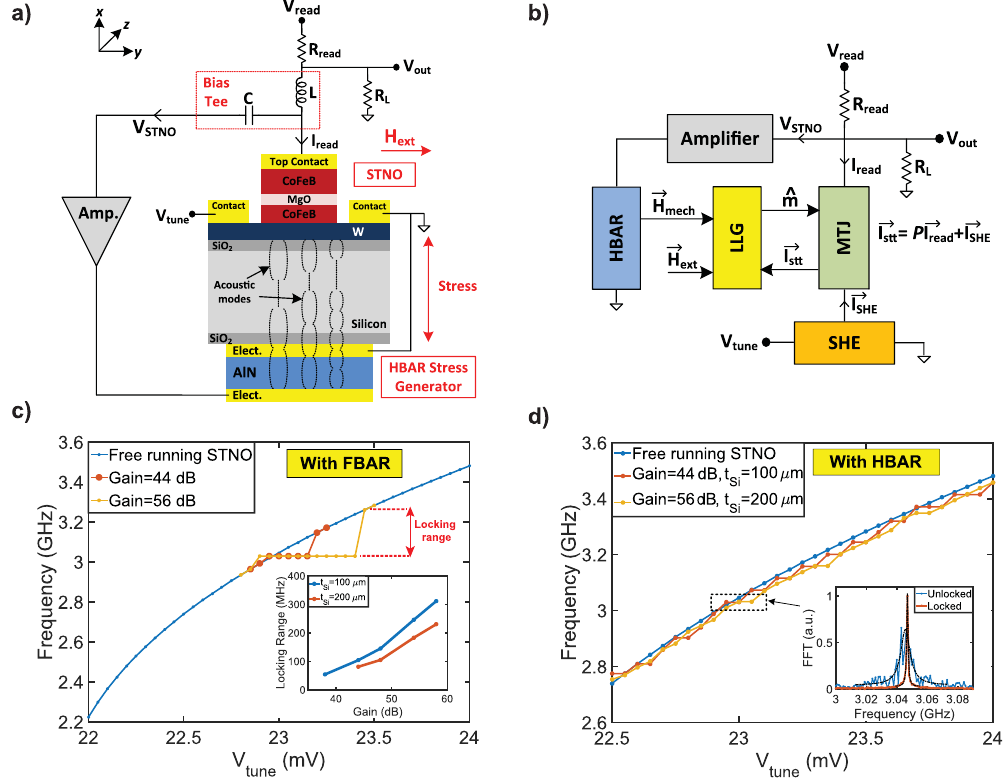
Figure 3. Implementation of MASH oscillator with strain feedback: ( a ) A three-terminal MTJ and 2-port HBAR are fabricated on the opposite sides of the same silicon substrate, and coupled to each other with strain due to the magnetostriction effect. ( b ) Modular modeling of transport, magnetization, and resonator dynamics. ( c ) Locking range versus amplifier gain for two different substrate thicknesses (100 μ m and 200 μ m) simulated with an FBAR where thicker substrate ( t Si = 200 μ m) requires larger gain since it can generate lower strain. ( d ) Tunability is achieved with V tune by locking the STNO to the nearest HBAR peak. The thickness of the substrate determines the tuning-steps by defining the spacing between the HBAR